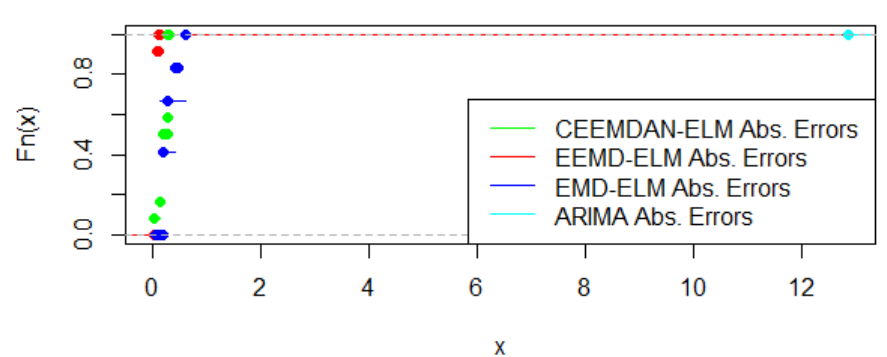
Figure 16. Empirical cumulative distribution function of US gas in 2019.